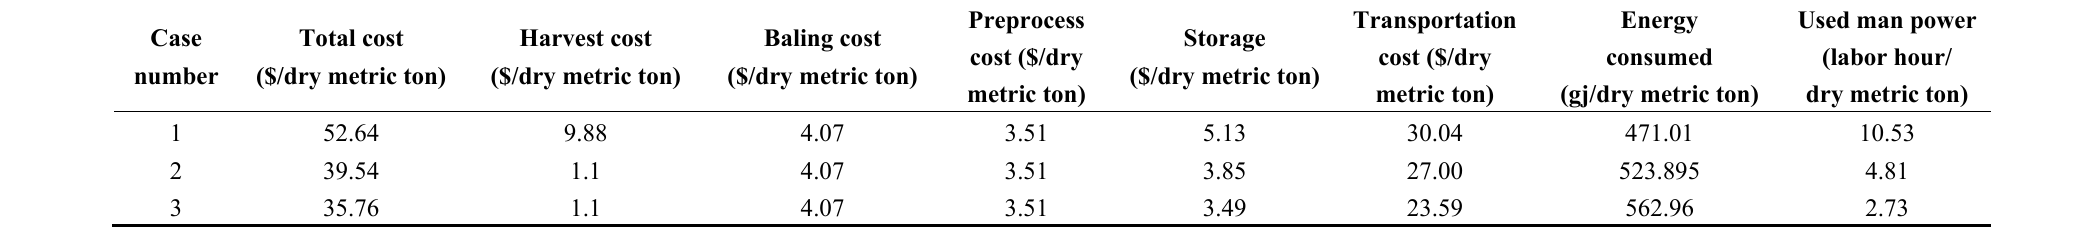
Table 2. 2012 logistics costs for sweet sorghum stalks in Inner Mongolia province